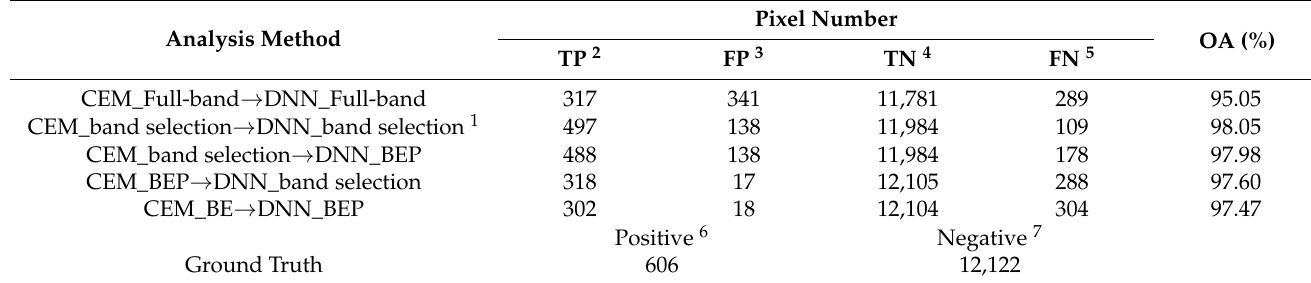
Table 3. Accuracy of DNN classification evaluated by the confusion matrix.